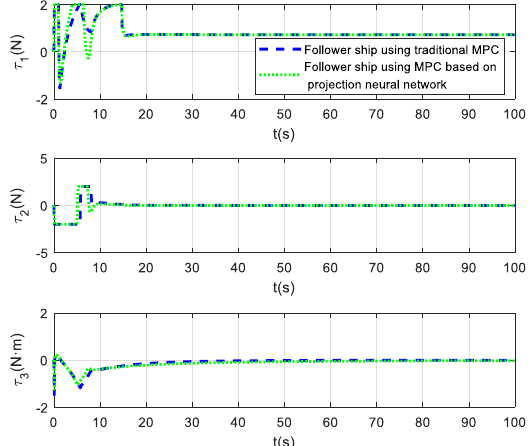
Figure 15. The responses of control inputs on simulation time.